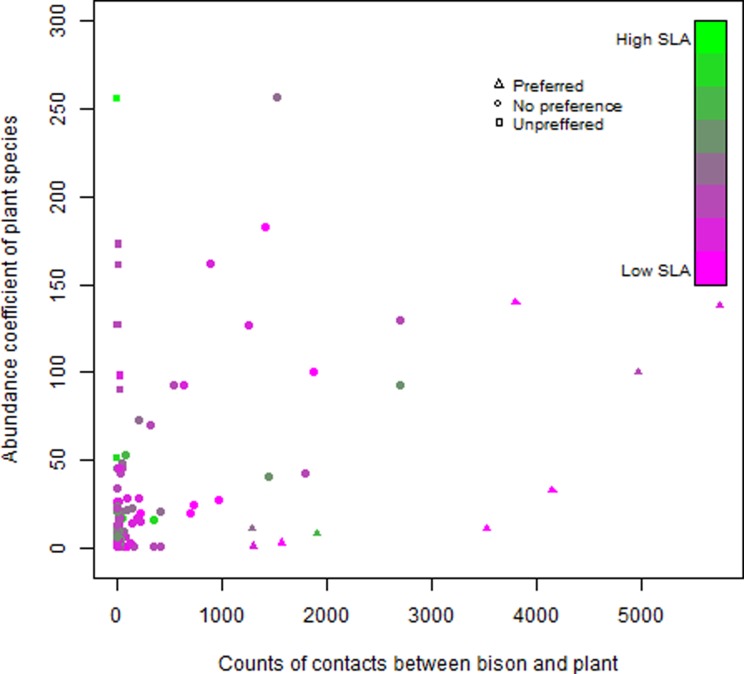
Relation between plant preference and SLA-values.Correlation between plant-bison contacts, availability of plant species, and SLA-values of plant species. Un-preferred plant species (rectangle) is characterized by being abundant while having few contacts with a bison, Preferred plant species (triangle) is characterized by having a low abundance while having many contacts with a bison, and plant species with no preference (circle) is characterized by having increasing contacts with a bison with increasing abundance. Figure adapted from Borowski and Kossak, 1972.